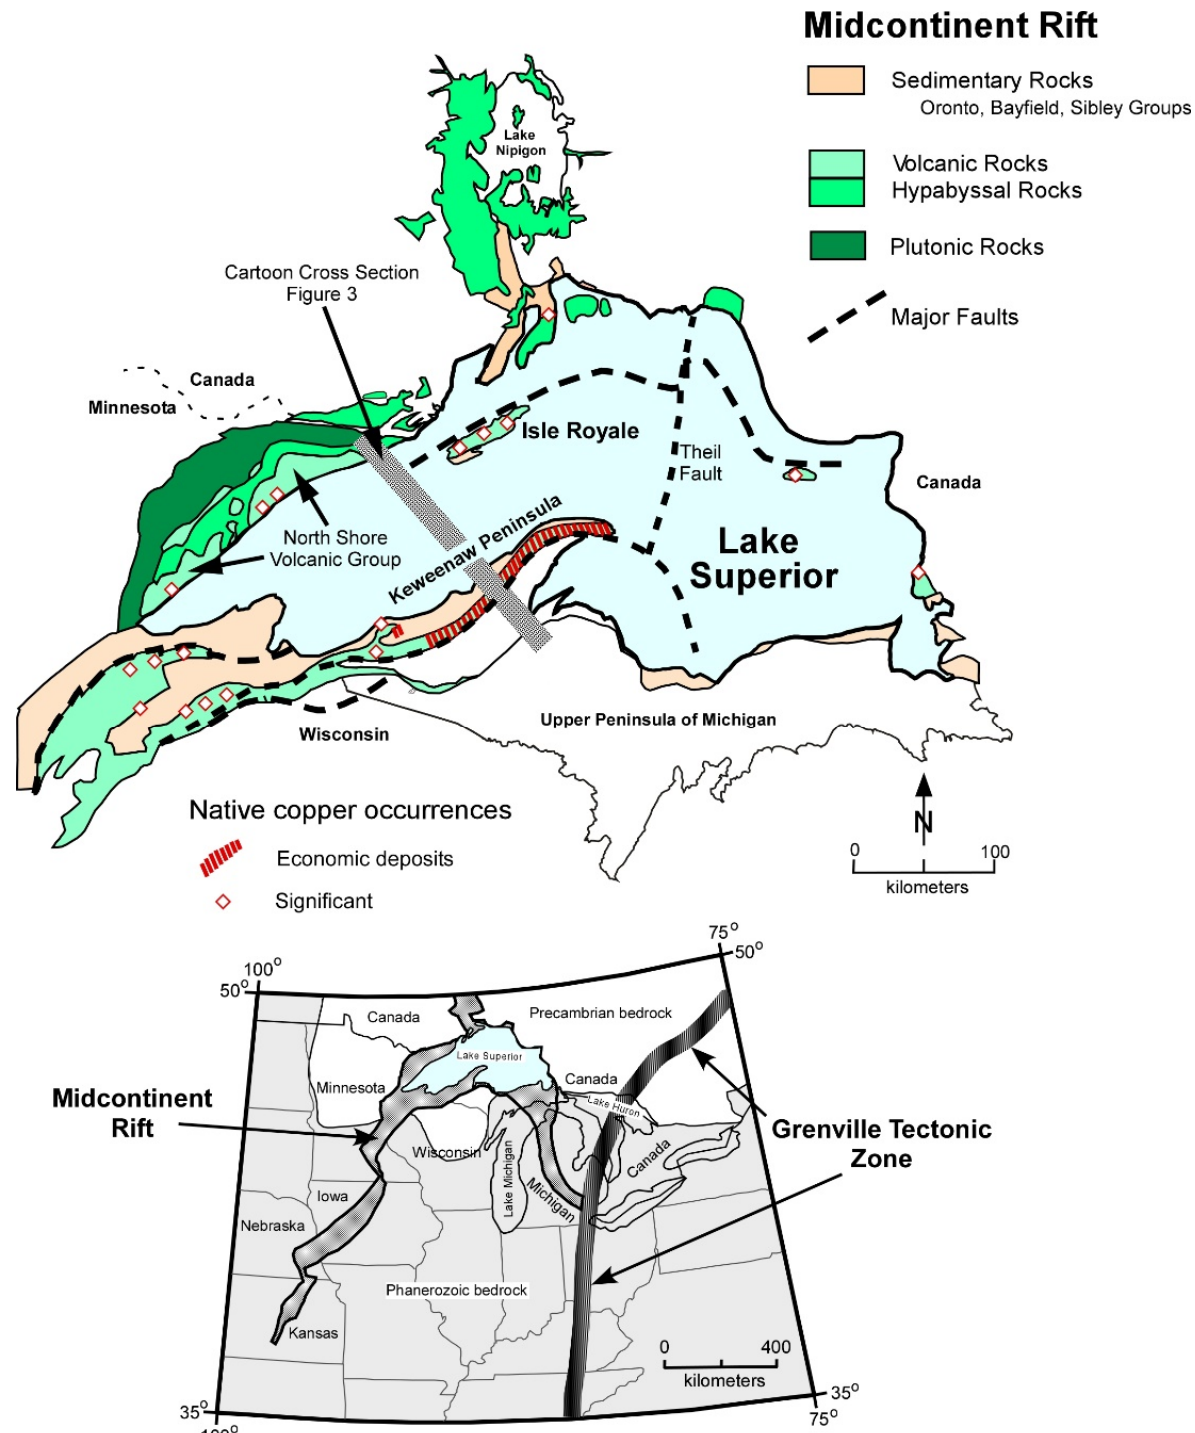
Figure 1. Geologic setting of the Mesoproterozoic Midcontinent Rift showing area of economic native copper deposits in the Keweenaw Peninsula and occurrences of native copper in exposed rocks of the Midcontinent Rift. The insert shows the front of the Grenville tectonic zone, a continent-continent suture that resulted in compression late in the history of the rift. Modified from Bornhorst and Lankton [2].